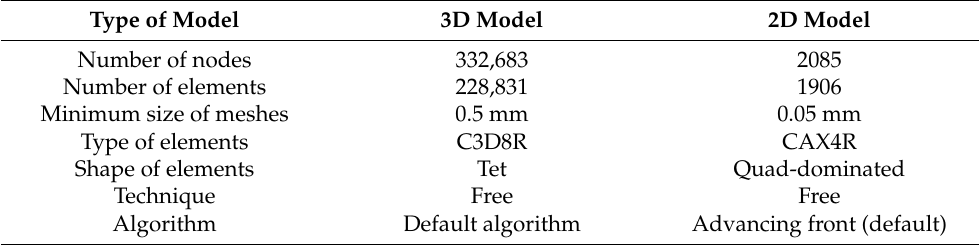
Table 5. Comparison of mesh parameters between 3D and 2D model of